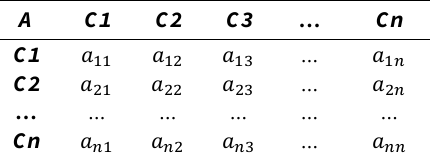
Table 2. Pairwise comparison matrix